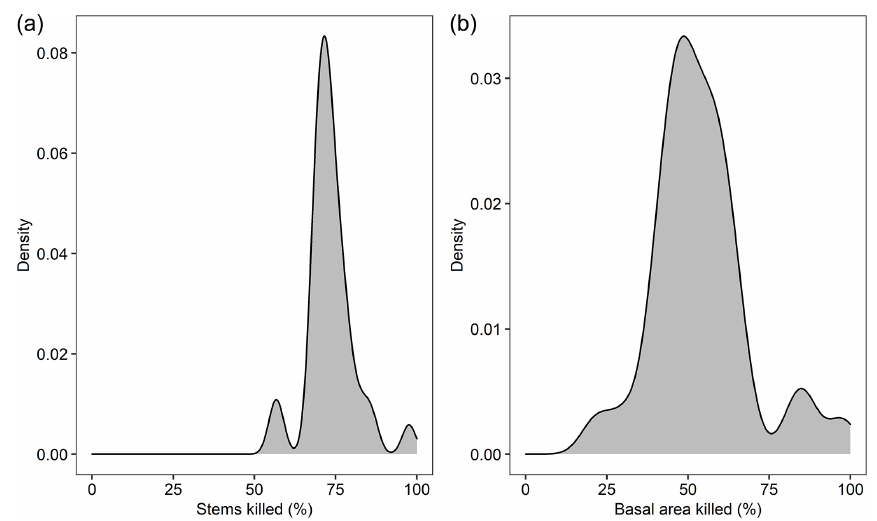
Figure B1. Simulated percent of (a) stems killed and (b) basal area killed by fire in a 61000ha forested landscape in interior Alaska. Model output is from simulation years 201–300.